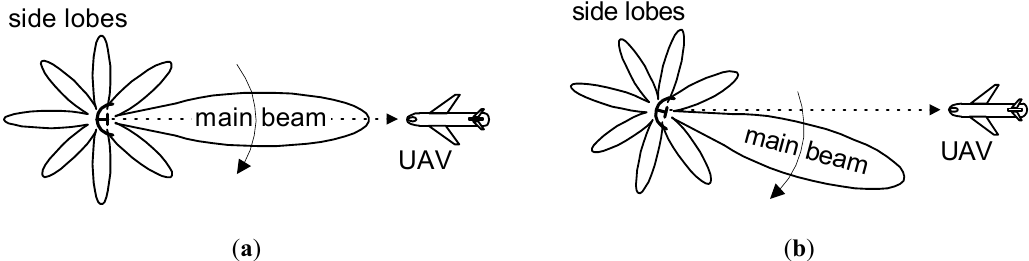
Figure 2. Top-view of the directional pattern for a rotating antenna showing ( a ) the main beam illuminating the unmanned aerial vehicle (UAV) at the selected moment t 1 and ( b ) a minimum of the radar antenna pattern directed on the UAV at the selected moment t 2 .